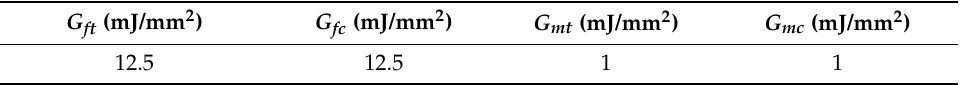
Table 2. Fracture energies of the fiber